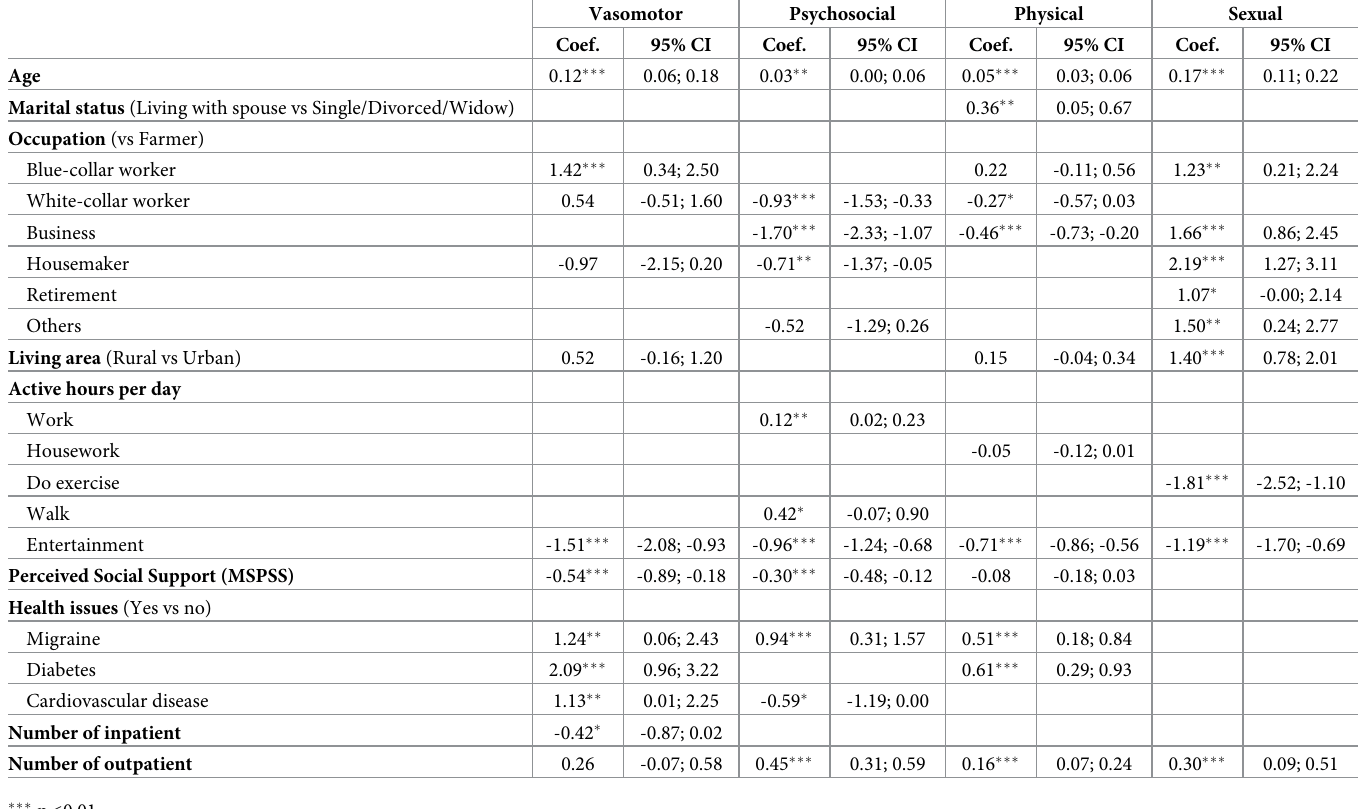
Table 4. Associated factors with MENQOL domain